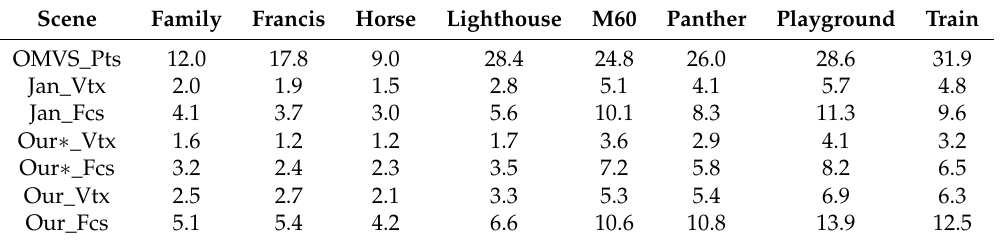
Table 5. Information of the 3D models evaluated on the intermediate set of Tanks and Temples dataset [40]. ∗ _Pts is the number of points in a 3D point cloud. ∗ _Vtx and ∗ _Fcs are the number of vertices and facets of a 3D mesh, respectively. The unit of all numbers is